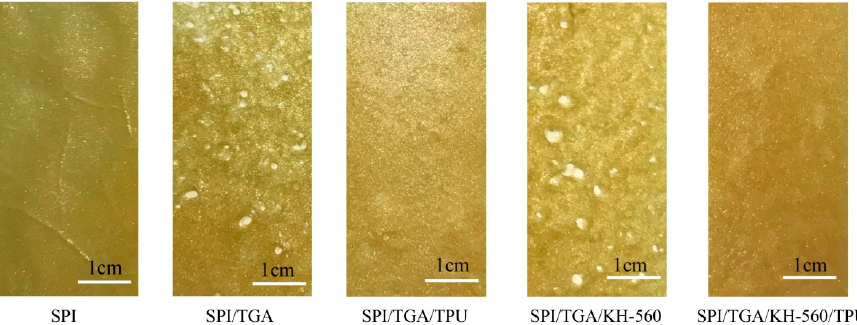
Figure 8. The cracks observation of the cured adhesive.